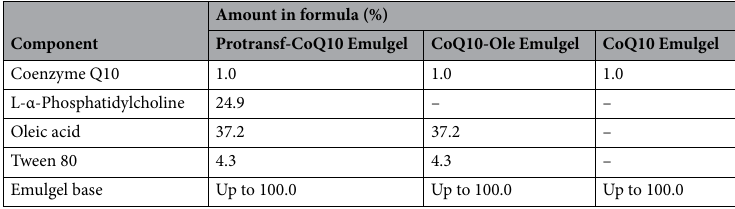
Table 2. Formulation of CoQ and protransfersomal CoQ10-loaded